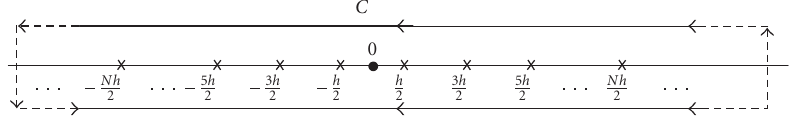
Figure 3.2. Integration path and poles for the integral representation of type 2 di ff